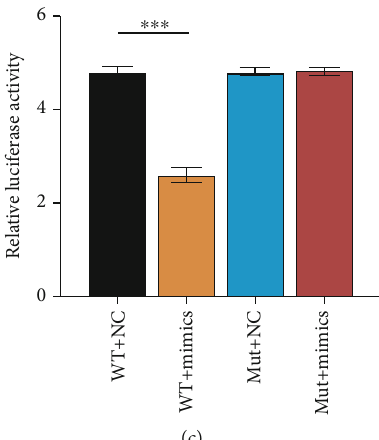
Figure 7: miR-450a-2-3p targets ERK1/2 (MAPK1). Protein (a) and mRNA (b) levels of ERK1/2 in CFs and HUVECS transfected with mimics or inhibitor were measured using western blot or RT-qPCR, respectively. The expression levels of mRNA and proteins were normalized to that of actin. (c) Relative luciferase activity of WT or mutant MAPK1 3 ′ -UTR reporter cotransfected with miR-450a-2-3p mimics. Data is presented as the mean ± SEM of three independent experiments. ∗ P < 0 : 05 , ∗∗ P < 0 : 01 , ∗∗∗ P < 0 : 001 , ∗∗∗∗ P < 0 : 0001